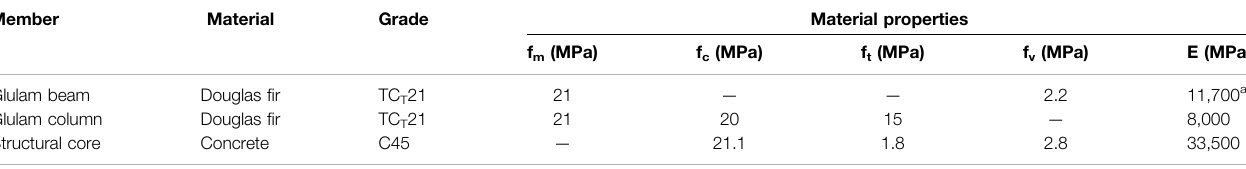
TABLE 1 | Structural member speci fi cations and material parameters (GB T 50708, 2012) (GB 50010-2012: Code for design of concrete structures, 2015). Member